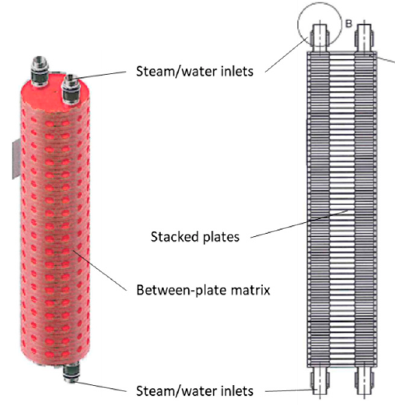
Figure 9. Plate–shell heat exchanger.